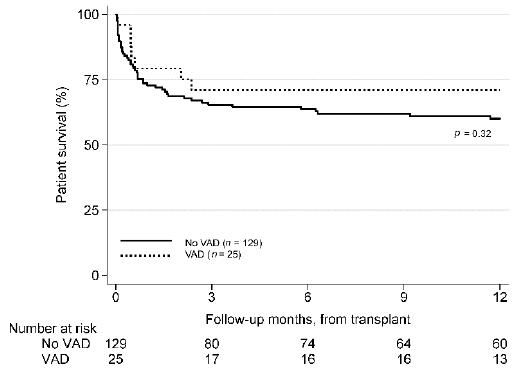
Figure 3. One year post-transplant survival. Kaplan Meier curves for one year post-listing survival is presented comparing patients supported with VAD during listing against those without. No difference in survival is seen between the two groups.